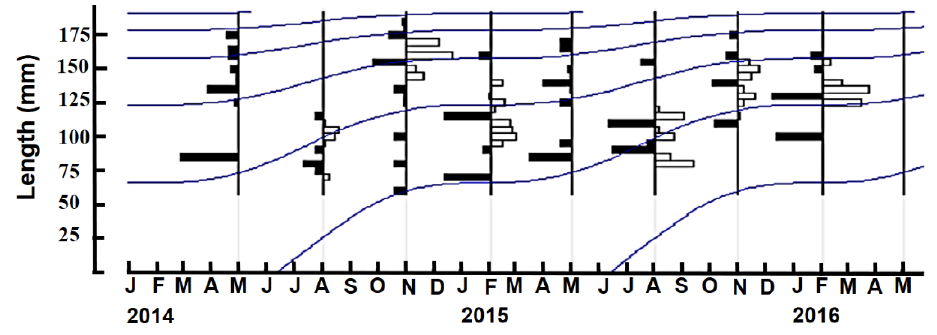
Figure 5. Size frequency data and the procedure using FiSAT II.